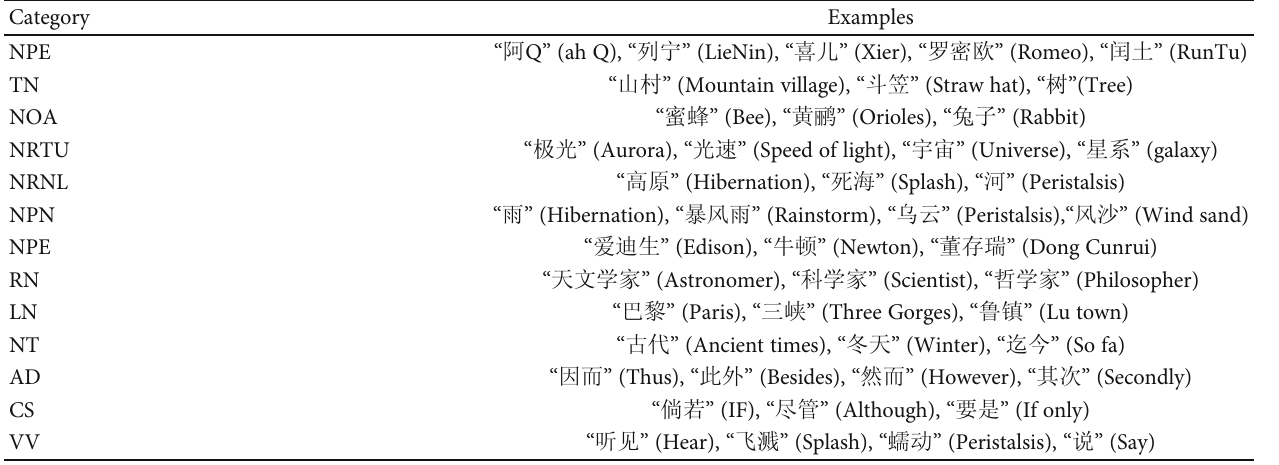
Table 7: Text book keyword list (Part).